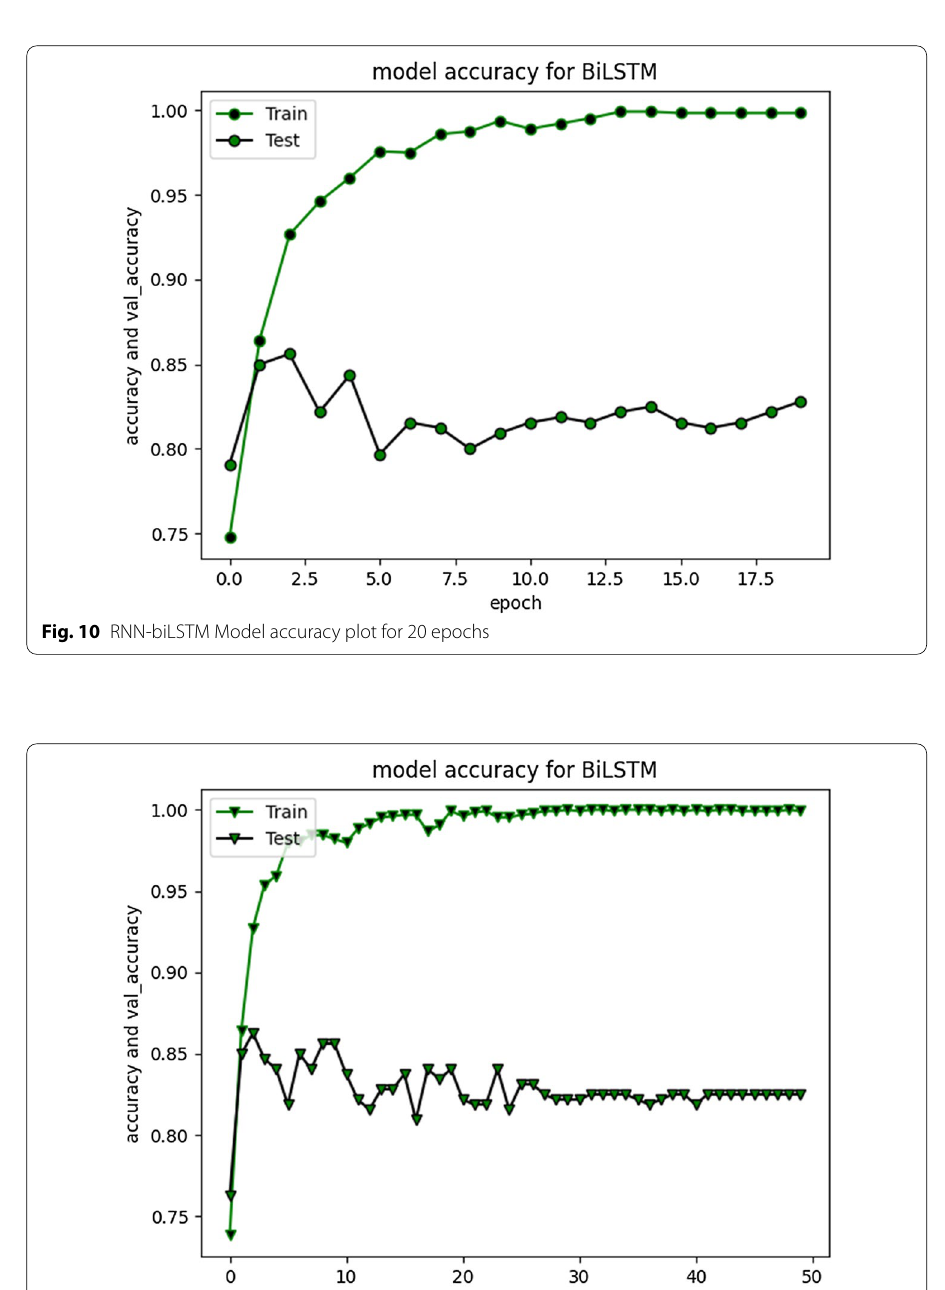
Figure 14 represents the evaluation results for CNN model.